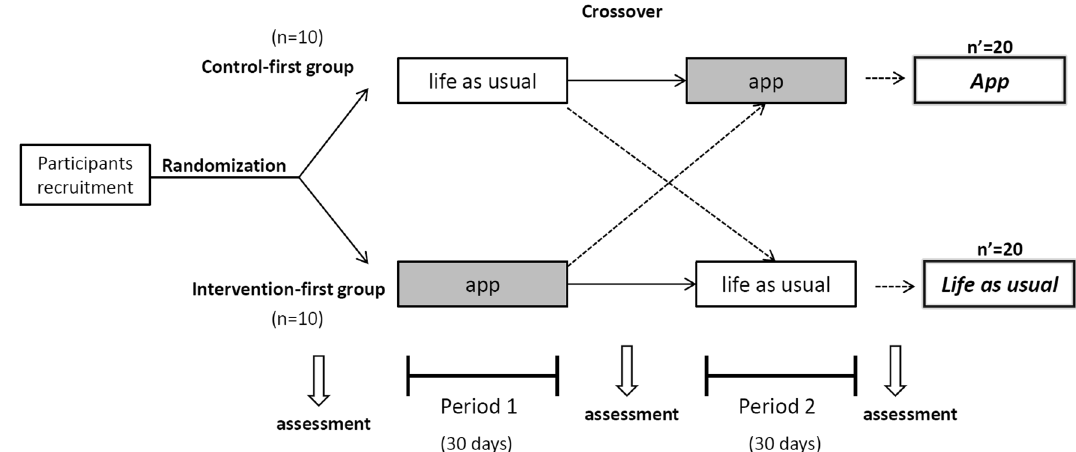
Figure 1. Randomization and flow of participants from baseline through day